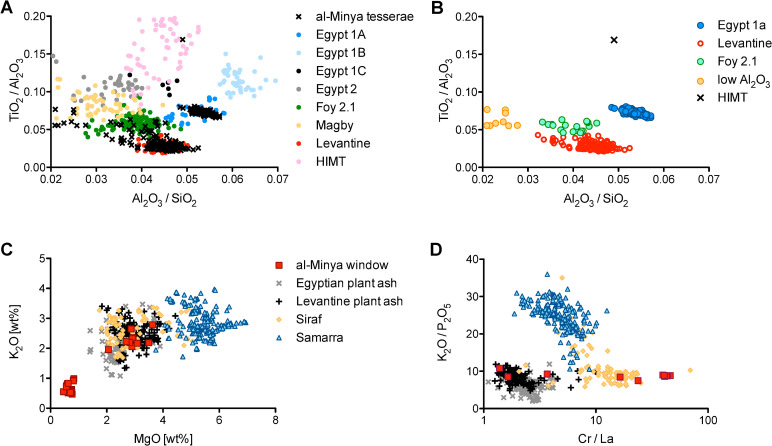
Base glass characteristics of the architectural glasses from Khirbat al-Minya.(A) TiO2/Al2O3 and Al2O3/SiO2 ratios of the tesserae in comparison with selected primary glass reference groups; (B) separating the tesserae according to their affiliations with primary production groups as reflected in their TiO2/Al2O3 and Al2O3/SiO2 ratios; (C) K2O and MgO concentrations of the window glasses compared to glass reference groups distinguishing natron from plant ash glasses; (D) K2O/P2O5 and Cr/La ratios differentiate between plant ash glasses from different geographical regions. Data sources: [1, 10, 36–47].